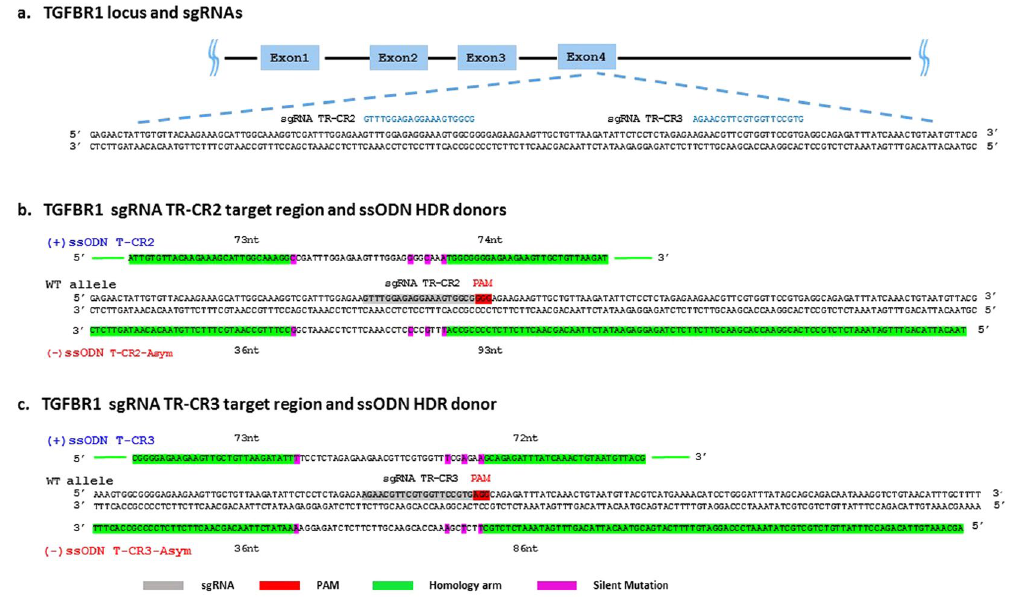
Figure 4. Guide RNAs and single-stranded oligonucleotide (ssODN) donor designs for gene editing at the TGFBR1 locus. ( a ) Two guide RNAs TR-CR2 and TR-CR3 were designed to specifically target TGFBR1 Exon4 and introduce different sequence alterations by HDR. TR-CR3 is 39 nucleotides downstream of TR-CR2. ( b ) Two ssODN HDR donors (T-CR2 and T-CR2-Asym) were designed to introduce a silent mutation 12 bp upstream of guide RNA TR-CR2 target site, with three silent mutations within the guide RNA recognition sequence to prevent re-editing of the HDR converted sequence. T-CR2 is a ( + ) strand HDR donor which is complementary to the guide RNA targeted cleavage strand with balanced homology arms around each side of the intended mutations (5 ′ -73nt and 3 ′ -74nt, respectively). T-CR2-Asym is a ( − ) strand HDR donor which is complementary to the guide RNA non-targeted strand with homology arms that differ in length (5 ′ -93nt and 3 ′ - 36nt, respectively). ( c ) Two ssODN donors (T-CR3 and T-CR3-Asym) were designed to introduce a known SNP 12 bp upstream of guide RNA TR-CR3 target site, with two silent mutations within the guide RNA recognition sequence and one silent mutation within the TR-CR3 PAM site to prevent re-editing of the HDR converted sequence. T-CR3 is a ( + ) strand HDR donor which is complementary to the guide RNA targeted strand with balanced length homology arms (5 ′ -73nt and 3 ′ -72nt, respectively) around each side of the intended mutations. T-CR3-Asym is a ( − ) strand HDR donor which is complementary to the guide RNA non-targeted strand with unbalanced length homology arms (5 ′ -86nt and 3 ′ -36nt, respectively) around each side of the intended